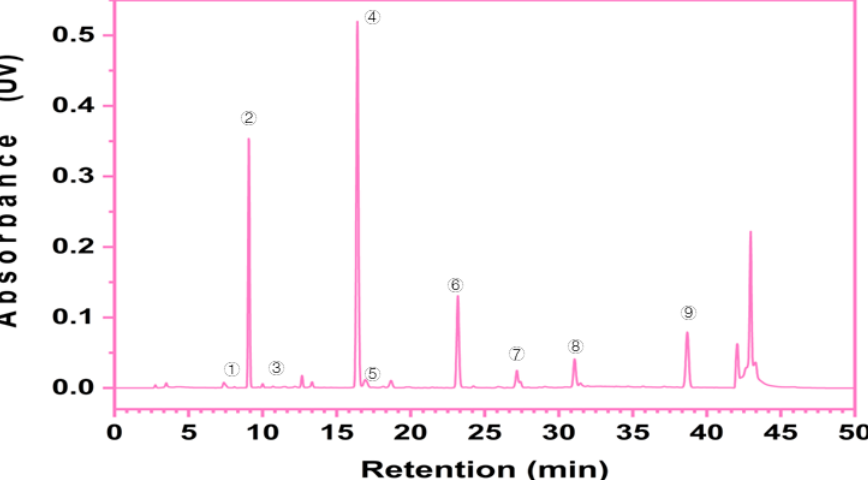
Figure 5. HPLC of identified glucosinolates from flowering Chinese cabbage sprouts (FCCS). ① PRO: Progoitrin; ② GRA: Glucoraphanin; ③ SIN: Sinigrin; ④ GNA: Gluconapin; ⑤ 4 − HGBS: 4-Hydroxy-Glucobrassicin; ⑥ GBN: Glucobrassicanapin; ⑦ GBS: Glucobrassicin; ⑧ 4 − MGBS: 4-Methoxy-Glucobrassicin; ⑨ NGBS: Neoglucobrassicin; 40 – 50 min is the time for an elution.